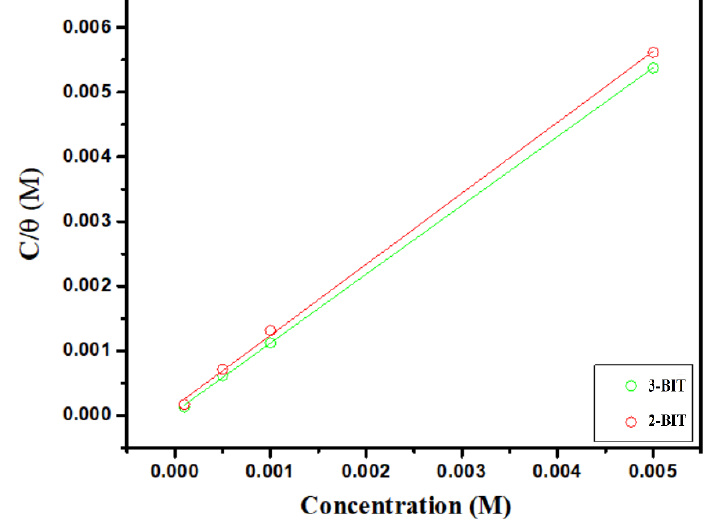
Figure 4. Langmuir adsorption isotherm of inhibitors 3-BIT and 2-BIT on the surface of the MS in 1.0 M HCl medium derived from weight loss measurement.